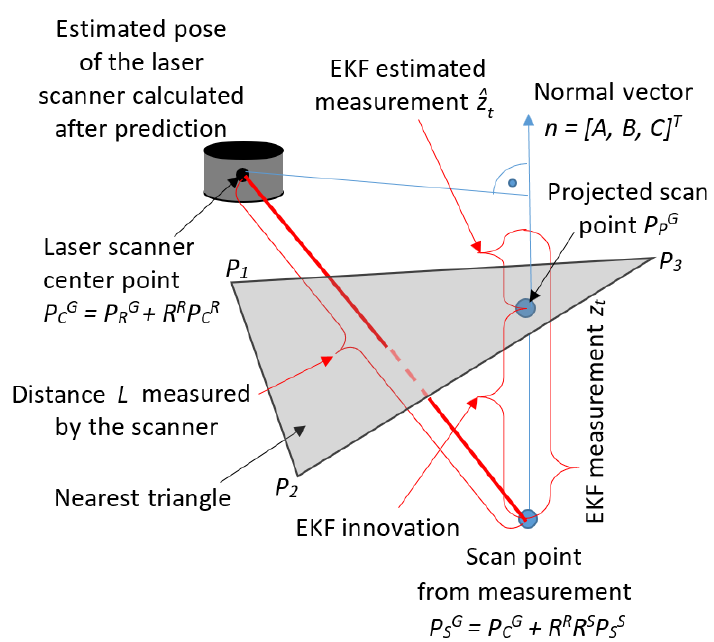
Figure 3. Innovation in the EKF (in this paper, we use the following notation for representing points: the subscript represents the name of the point and the superscript indicates the coordinate system: G—global, R—robot, or